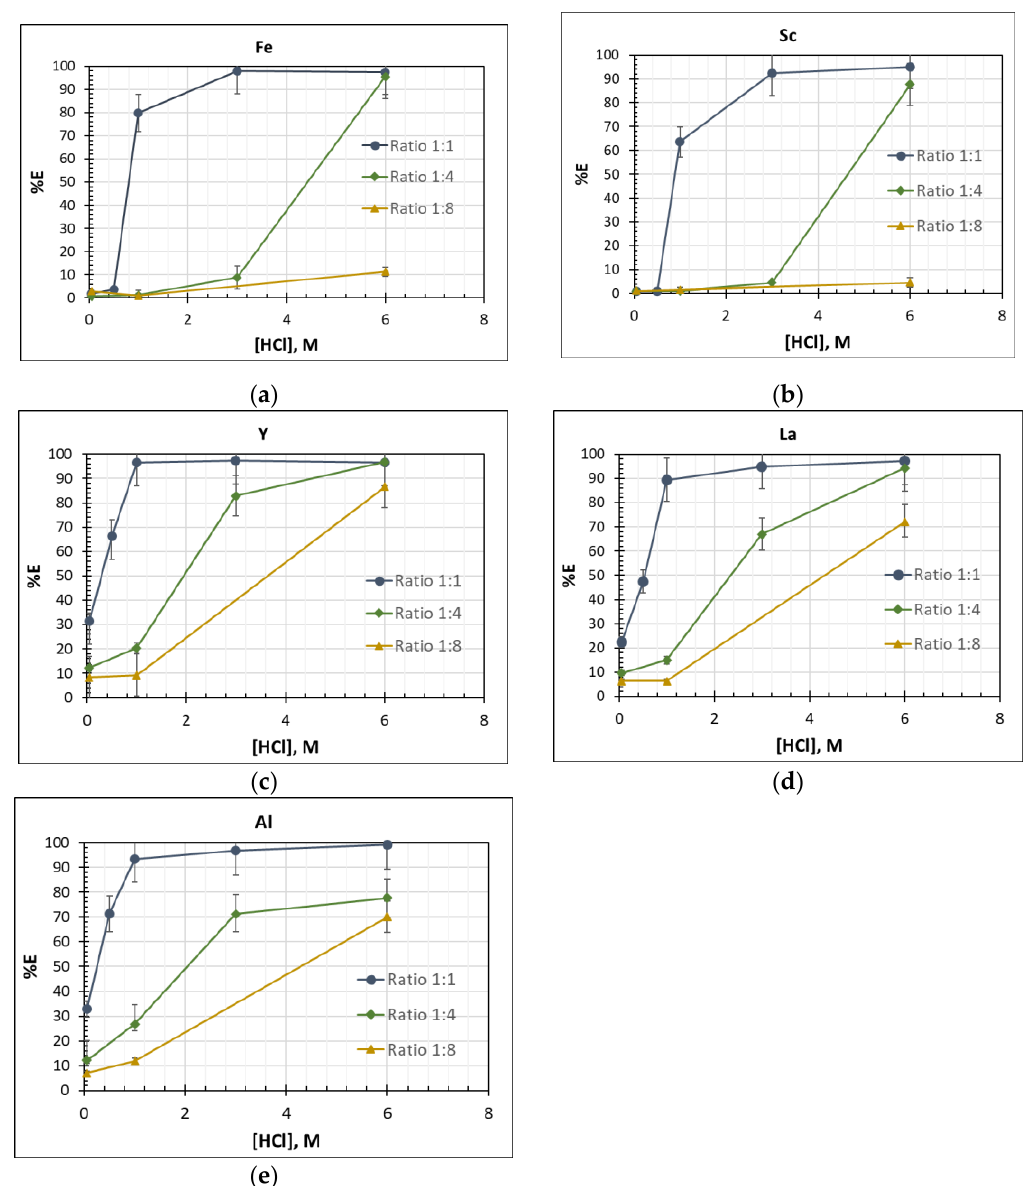
Figure 2. Extraction of each metal of interest as a function of HCl concentration in three different volume Ratios of acid:IL-PLS: ( a ) Fe, ( b ) Sc, ( c ) Y, ( d ) La, ( e ) Al.